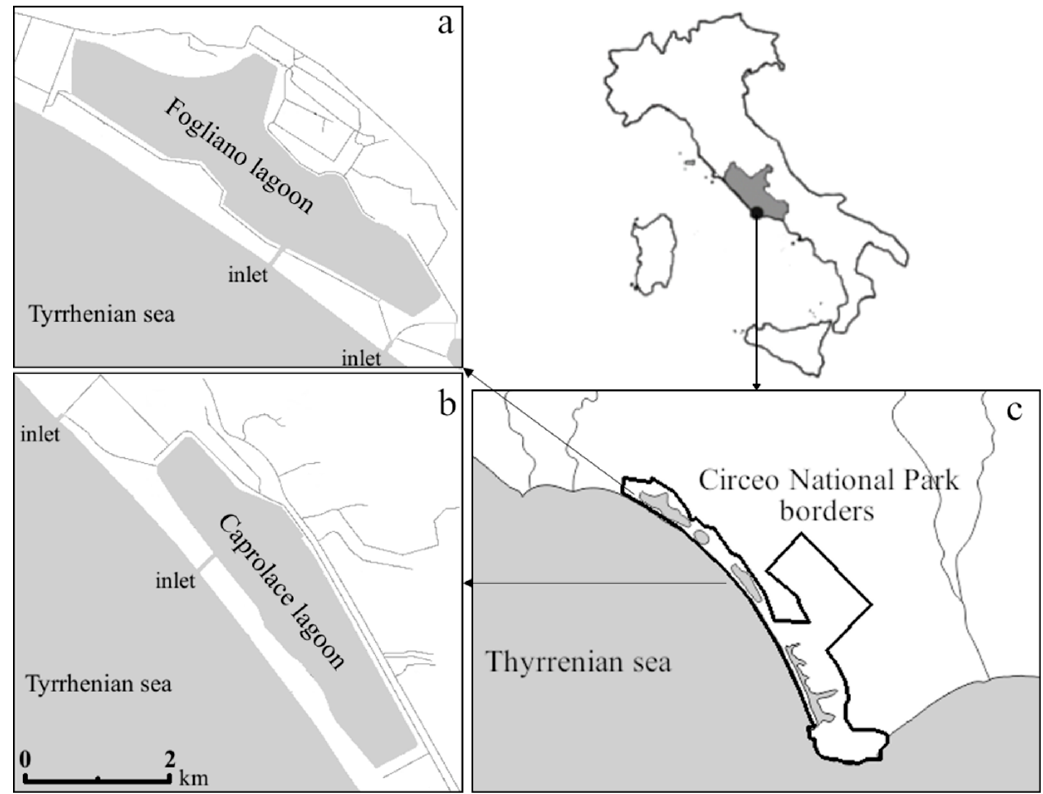
Figure 1. Study sites: the two coastal lagoons of Fogliano ( a ) and Caprolace ( b ) in the Circeo National Park, Central Italy ( c ). Table 1. Geo-morphological and hydrographic features of the two coastal lagoons of the Circeo National Park, Fogliano and Caprolace. Both lagoons fall in the category of non-tidal (<50 cm), euhaline lagoons (average 30 psu) of the Mediterranean ecoregion according to the classification of the transitional water under Directive 2000/60 EC (WFD).